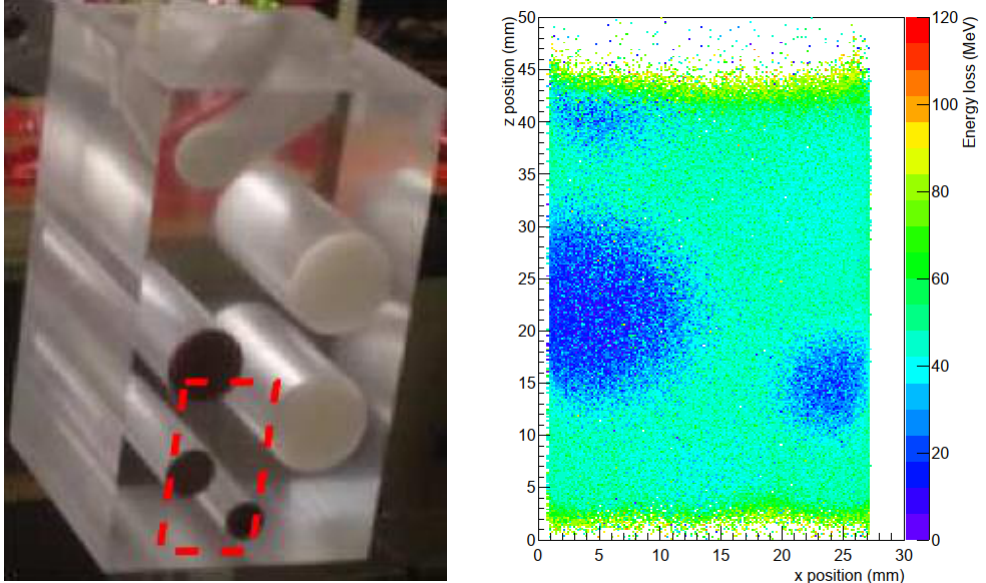
Figure 12. On the left, the portion of the phantom used in the test, on the right the final reconstructed image. The total exposure time was 100 s at a beam intensity of 3 kHz [25] .